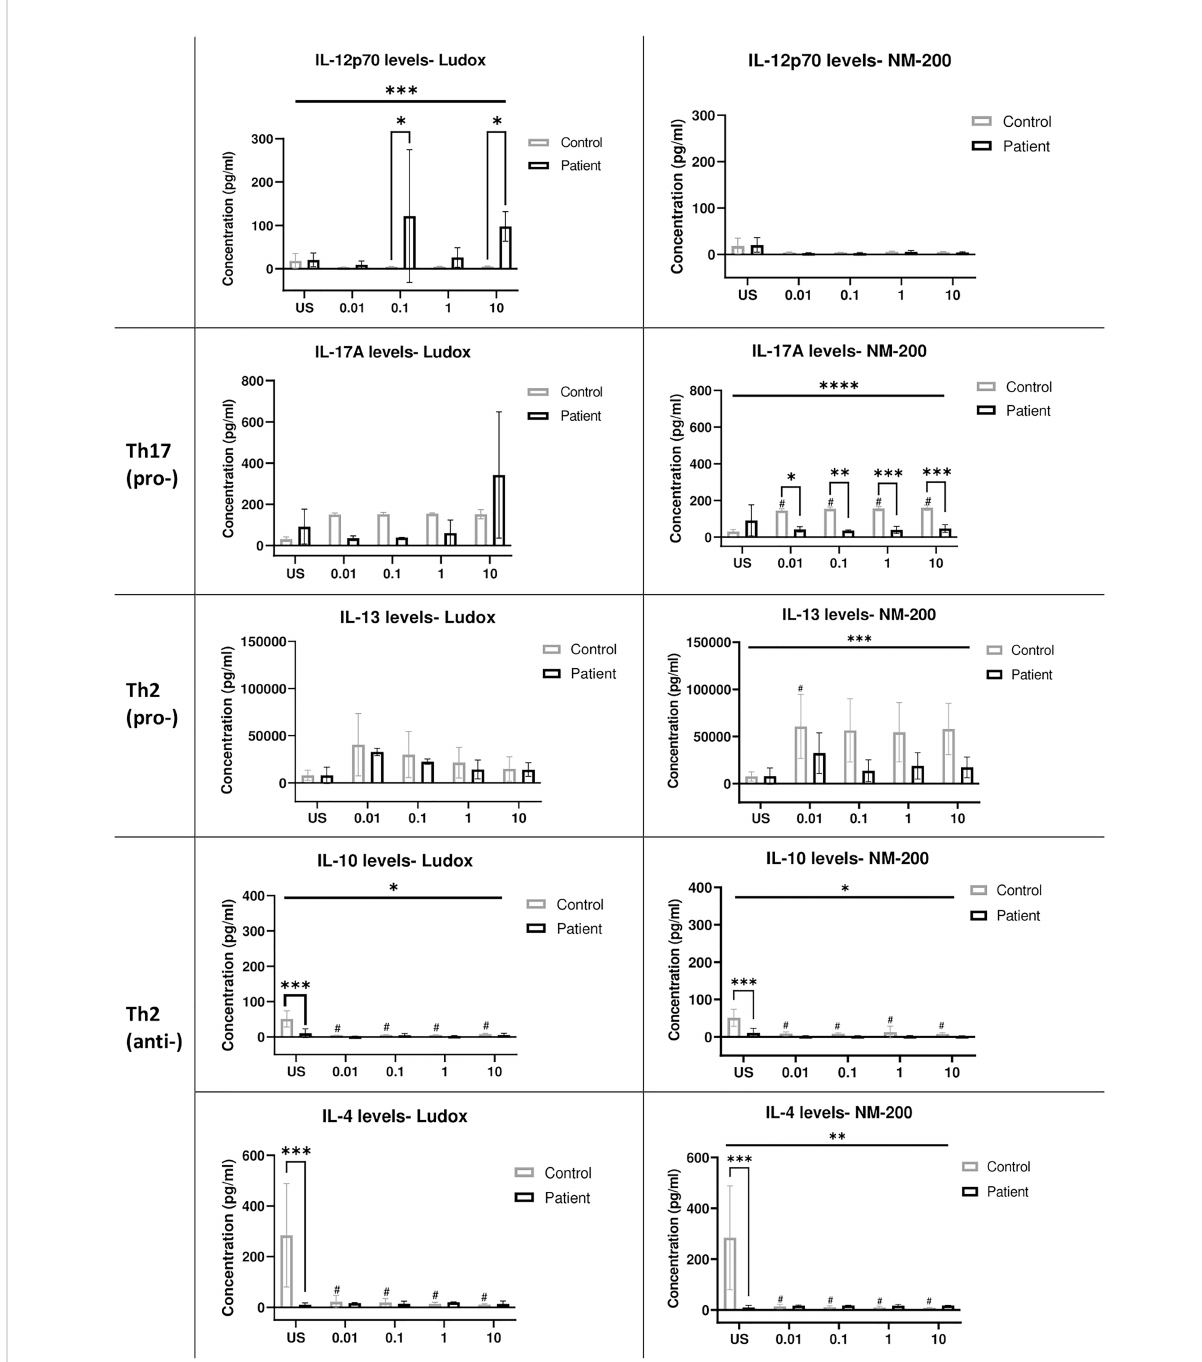
FIGURE 6 (Continued) Cytokine secretion pro fi les of silicotic and healthy subjects on day 7. The cytokine mediated immune response in silicosis patients and controls were determined on day 7 with an ELISA for pro-in fl ammatory (pro-) cytokines generated by multiple (Th1/ Th2) cells: TNF- a , IL-6, IL-1 b , GM-CSF; Th1 cells: IFN- g , IL-12p70; Th17 cells: IL-17A and Th2 cells: IL-13. Anti-in fl ammatory (anti-) Th2 cytokines: IL-10 and IL-4 were also evaluated between both groups. Tukey ’ s multiple comparisons tests via two-way ANOVA was performed to determine signi fi cance of cytokine levels secreted in response to SiNP concentrations against unstimulated condition within each subject group, # signi fi cant at p < 0.05 and between the two groups of subjects per exposure condition; *p < 0.05, **p < 0.01 and ***p < 0.001. ANOVA F-tests or level of signi fi cance between both groups regardless of exposure conditions are denoted by *p < 0.05, **p < 0.01, ***p < 0.001 and ****p < 0.0001. Non-signi fi cance (NS) within and between groups are not included. US, Unstimulated. NS, non-signi fi